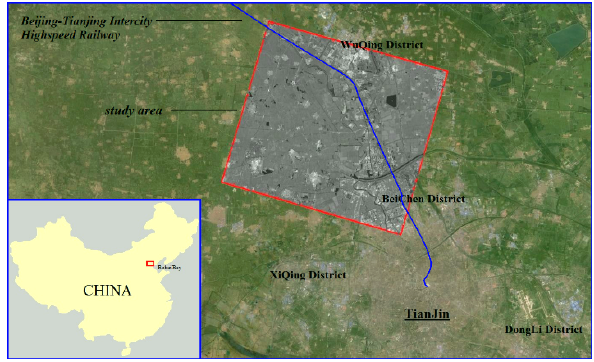
Figure 2. Location map of the study area